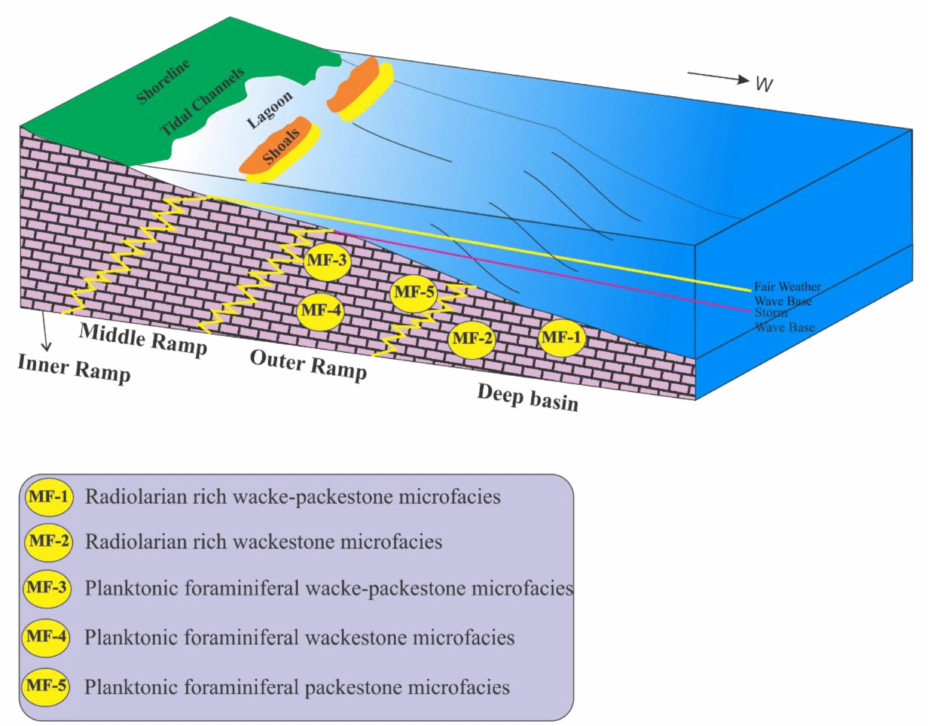
Figure 6. Proposed depositional model of the Goru Formation at Chutair Section, Sulaiman